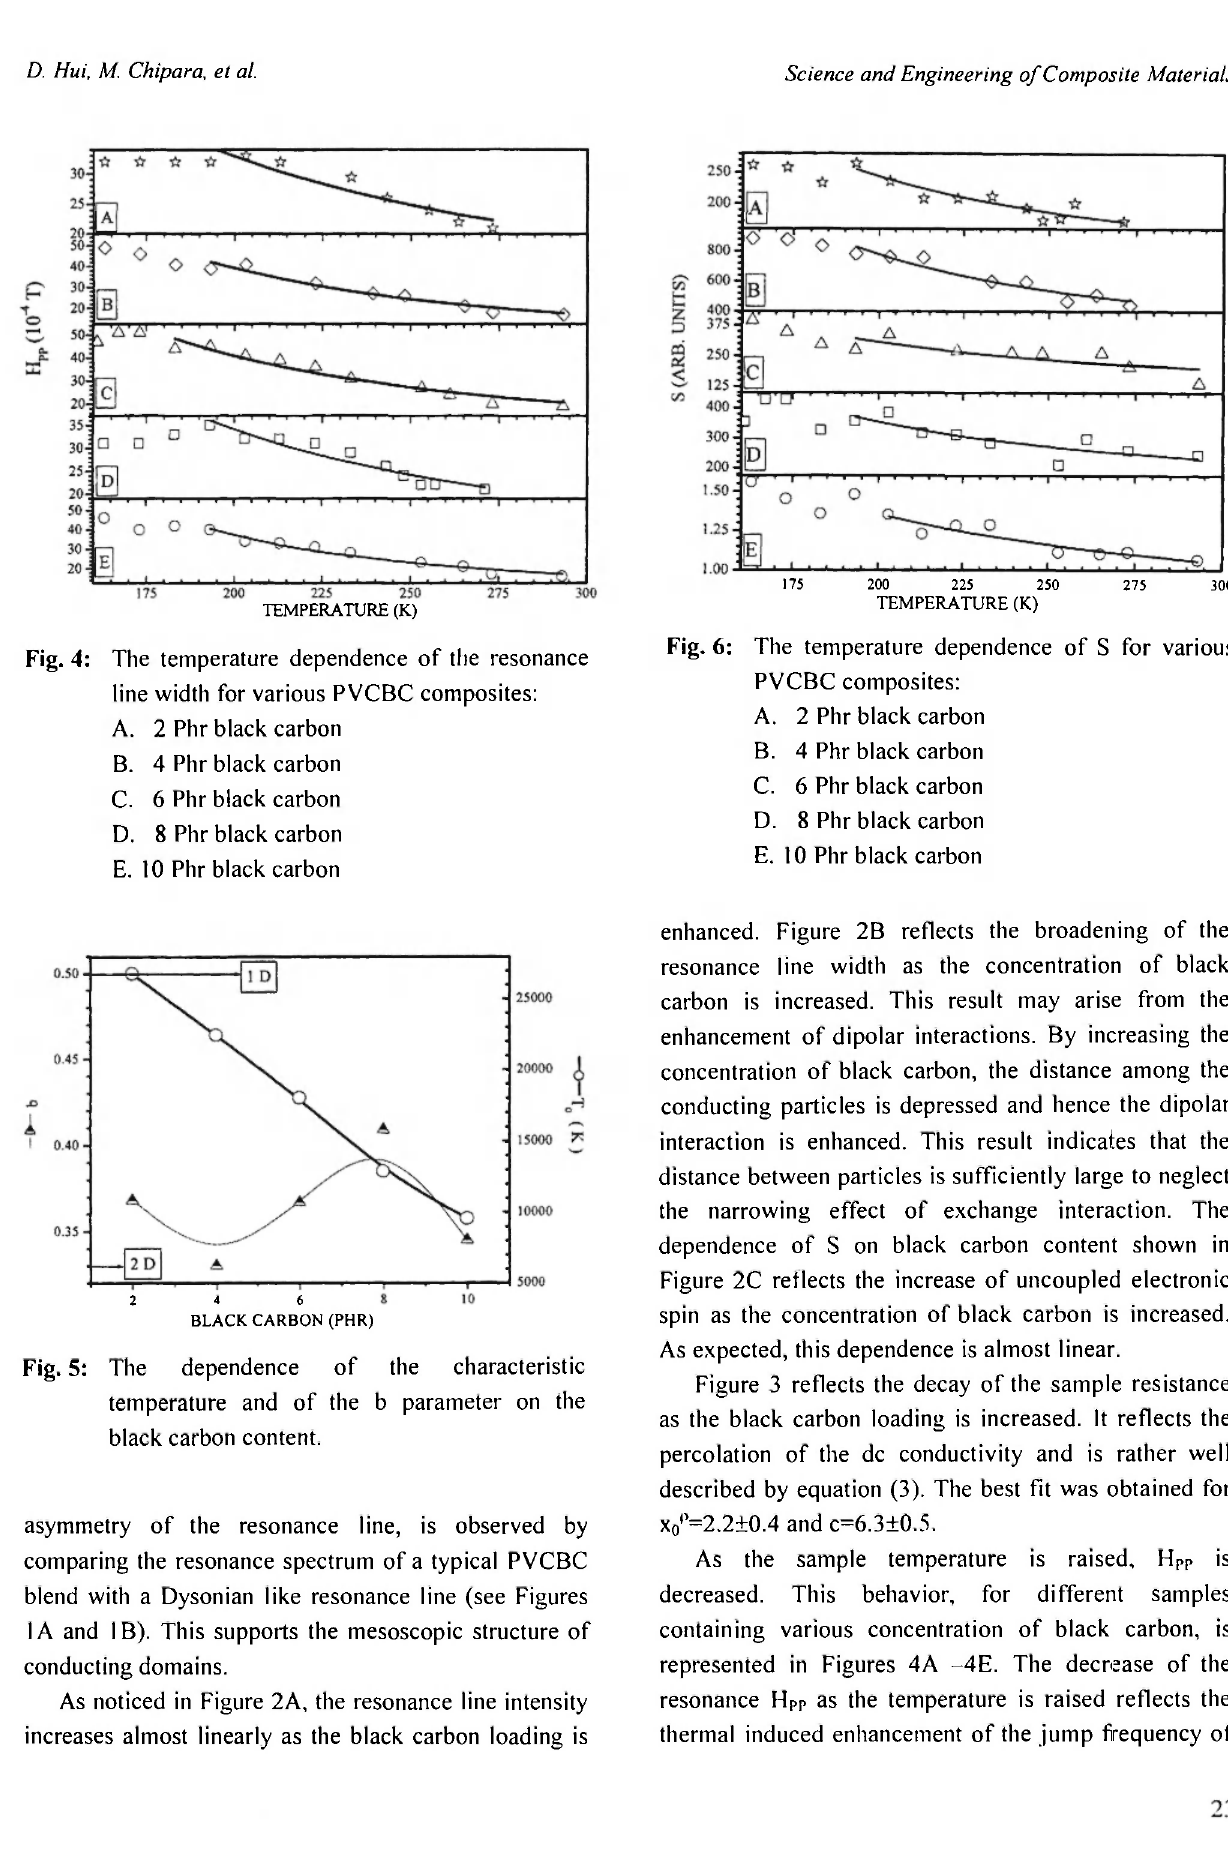
Fig. 6: The temperature dependence of S for various PVCBC composites: